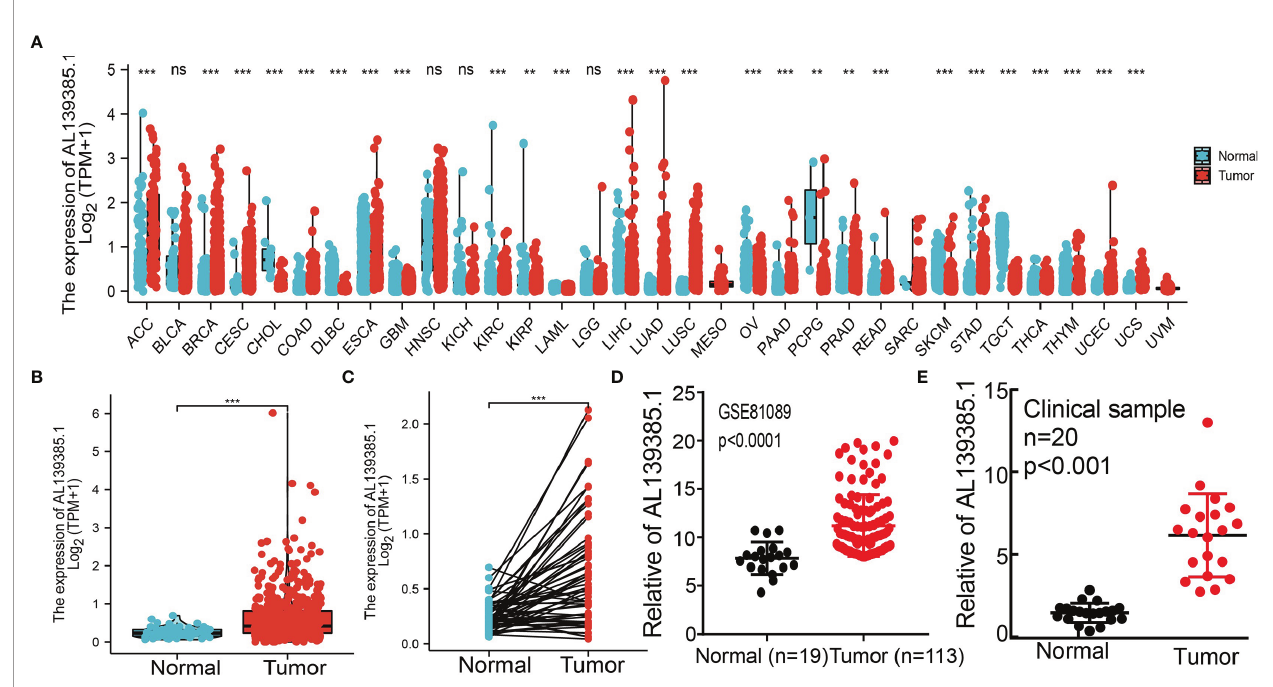
FIGURE 1 | AL139385.1 was overexpressed in LUAD. (A) AL139385.1 was highly expressed in 14 of the 33 cancers compared with normal tissue. (B – D) AL139385.1 was overexpressed in LUAD examine by TCGA and GEO datasets. (E) Relative AL139385.1 expression detected by RT-qPCR in 20 paired lung cancer and noncancerous tissues. ACC, adrenocortical carcinoma; BLCA, bladder urothelial carcinoma; BRCA, breast invasive carcinoma; CESC, cervical squamous cell carcinoma and endocervical adenocarcinoma; CHOL, cholangiocarcinoma; COAD, colon adenocarcinoma; DLBC, lymphoid neoplasm diffuse large B-cell lymphoma; ESCA, esophageal carcinoma; GBM, glioblastoma multiforme; HNSC, head and neck squamous cell carcinoma; KICH, kidney chromophobe; KIRC, kidney renal clear cell carcinoma; KIRP, kidney renal papillary cell carcinoma; LAML, acute myeloid leukemia; LUAD, brain lower grade glioma; LIHC, liver hepatocellular carcinoma; LUAD, lung adenocarcinoma; LUSC, lung squamous cell carcinoma; MESO, mesothelioma; OV, ovarian serous cystadenocarcinoma; PAAD, pancreatic adenocarcinoma; PCPG, pheochromocytoma and paraganglioma; PRAD, prostate adenocarcinoma; READ, rectum adenocarcinoma; SARC, sarcoma; SKCM, skin cutaneous melanoma; STAD, stomach adenocarcinoma; TGCT, testicular germ cell tumors; THCA, thyroid carcinoma; THYM, thymoma; UCEC, uterine corpus endometrial carcinoma; UCS, uterine carcinosarcoma; UVM, uveal melanoma. NS: P> 0.05, **P<0.01, and